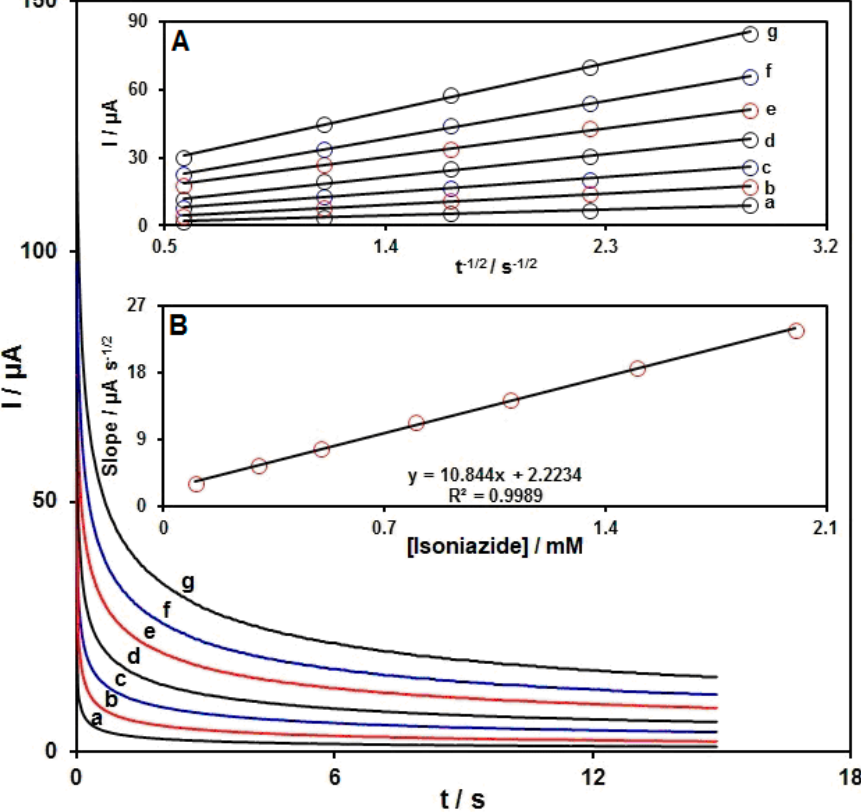
Figure 7. The chronoamperograms obtained on MoS 2 NSs-SPE in PBS (0.1 M, pH = 7.0) for various INZ contents; a–g: 0.1 mM, 0.3 mM, 0.5 mM, 0.8 mM, 1.1 mM, 1.5 mM, and 2.0 mM of INZ, respectively. Inset ( A ): the plot of I against t − 1/2 seen by chronoamperograms from a to g. Inset ( B ): the slope from the plot of straight line against INZ content.